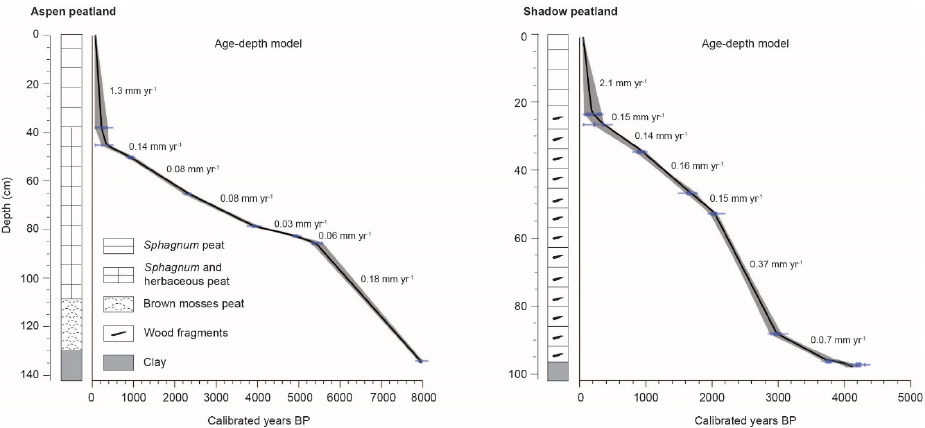
Figure 5. Stratigraphy and age ‐ depth model of the sedimentary cores collected at the Aspen and Shadow peatlands. Shadow peatlands. Table 2. Radiocarbon ages from Aspen and Shadow peatlands, calibrated with an IntCal13